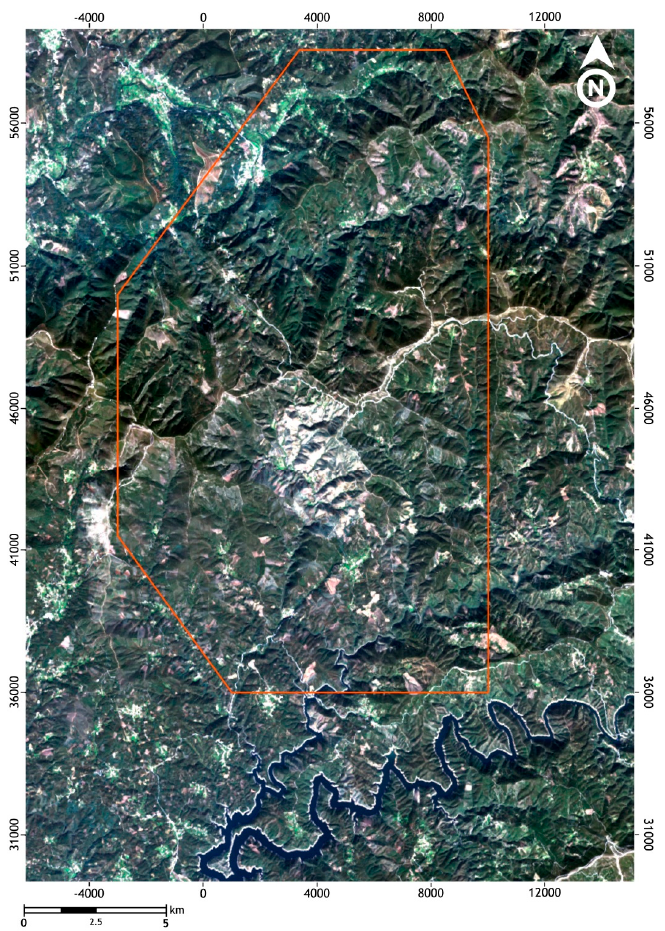
Figure 6. True colour RGB composite (4-3-2) of the selected Landsat 8 scene.